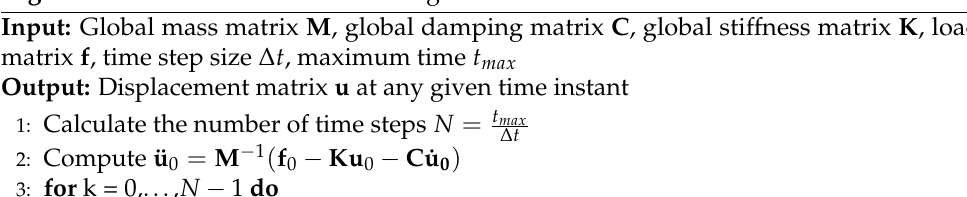
Algorithm A1 The Newmark time integration